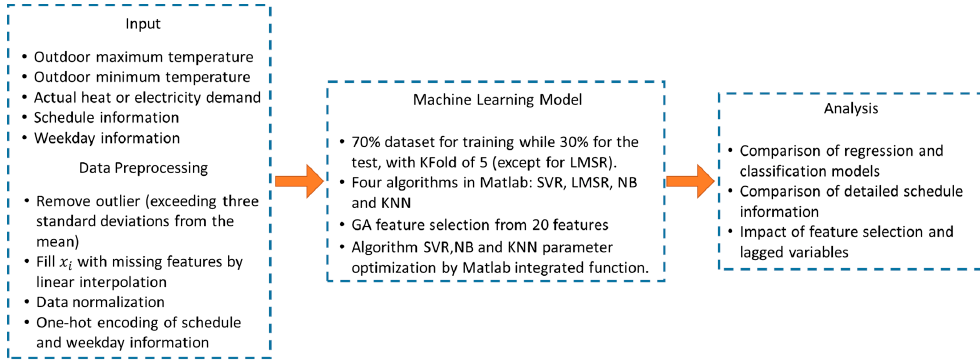
Figure 2. Analysis work flow.